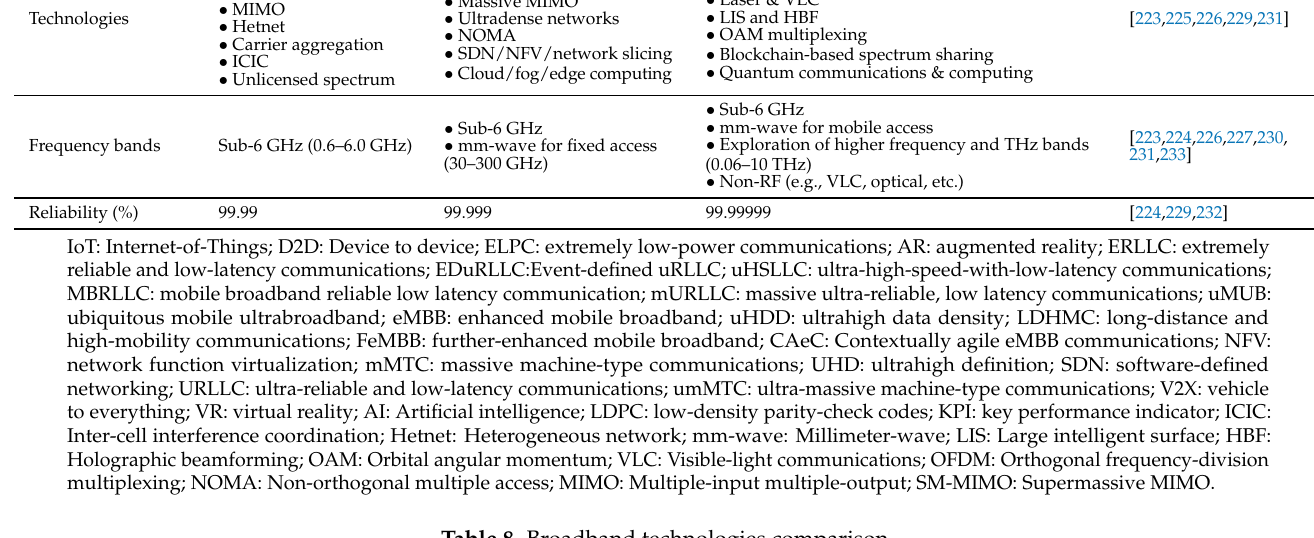
Table 8. Broadband technologies